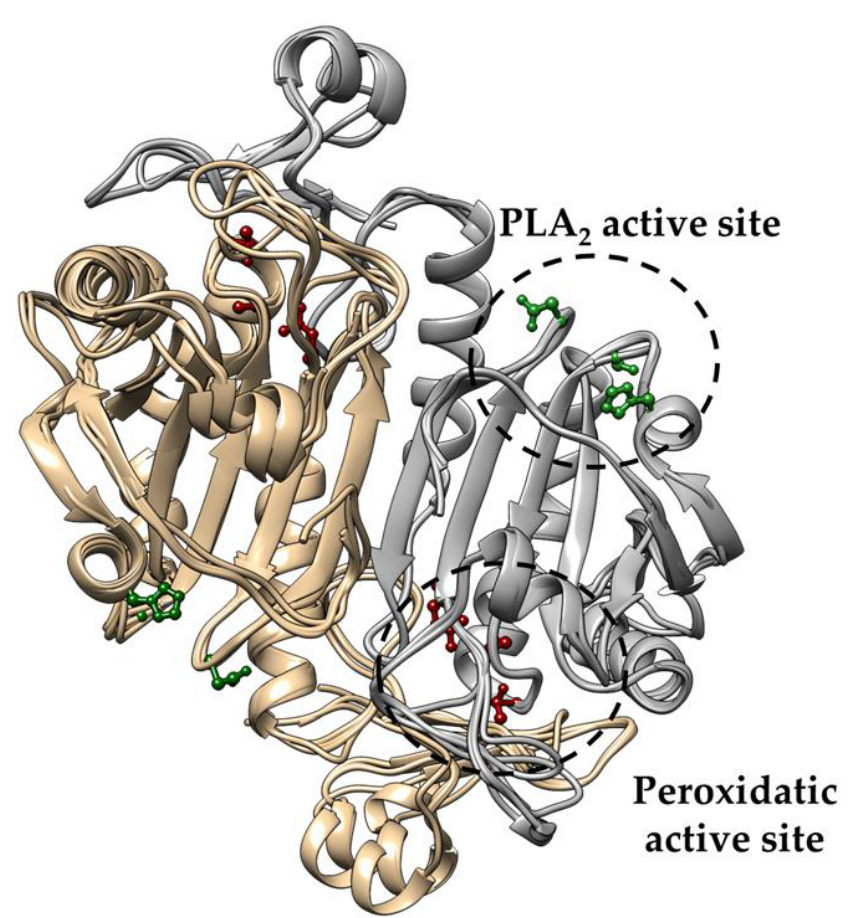
Figure 3. Superposition of the predicted structures of Prdx6 from T. aestivum , A. thaliana , P. aeruginosa, A. fumigatus (AfPrx1 and AfPrxC). One monomer is represented in copper and the other in gray in the antiparallel dimers. The PLA 2 catalytic triad is depicted in green, and the peroxidatic catalytic triad in red. The predicted structures were generated using human Prdx6 as modeled by the SWISS-MODEL tool (https://swissmodel.expasy.org/).